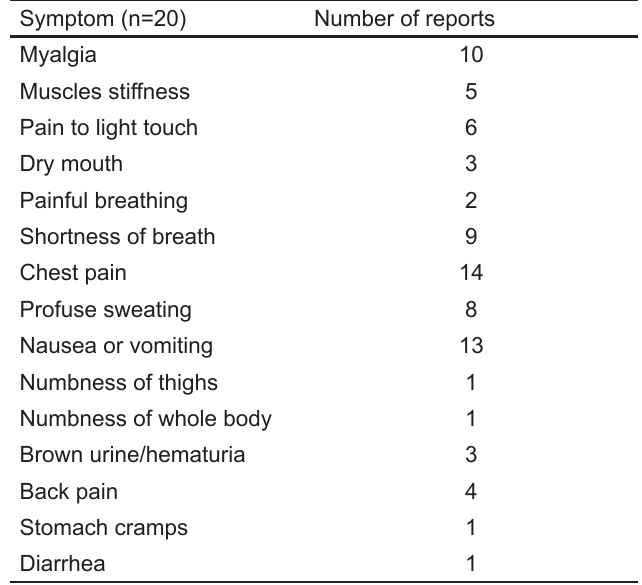
Table. Symptoms of Haff Disease cases, United States, 1997, 2001, 2013,